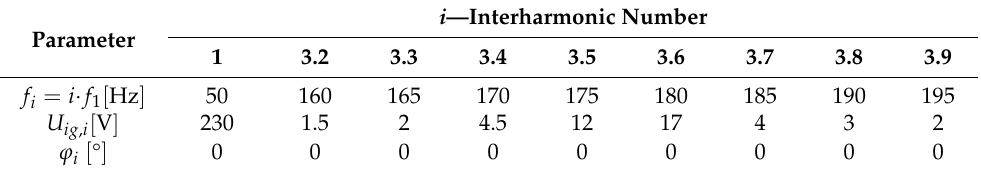
Table 4. Interharmonic signal parameters.